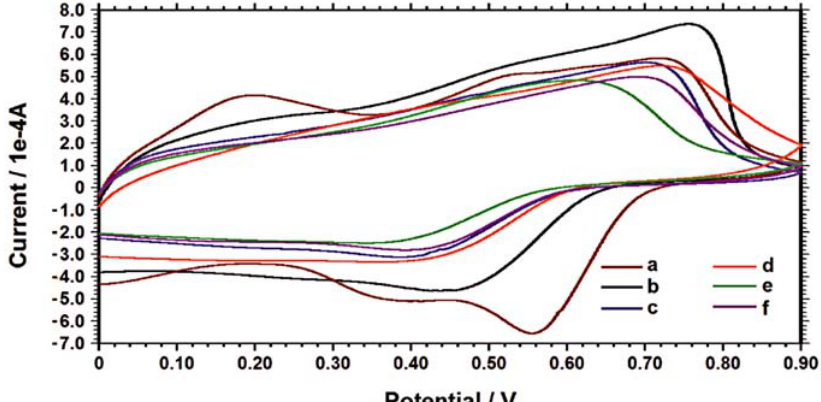
Figure 2. Electrochemical behavior of the PANI – P3MT – PDAB film in SBS at pH values of (a) 1.0, (b) 2.0, (c) 3.0, (d) 4.0, (e) 5.0, and (f)